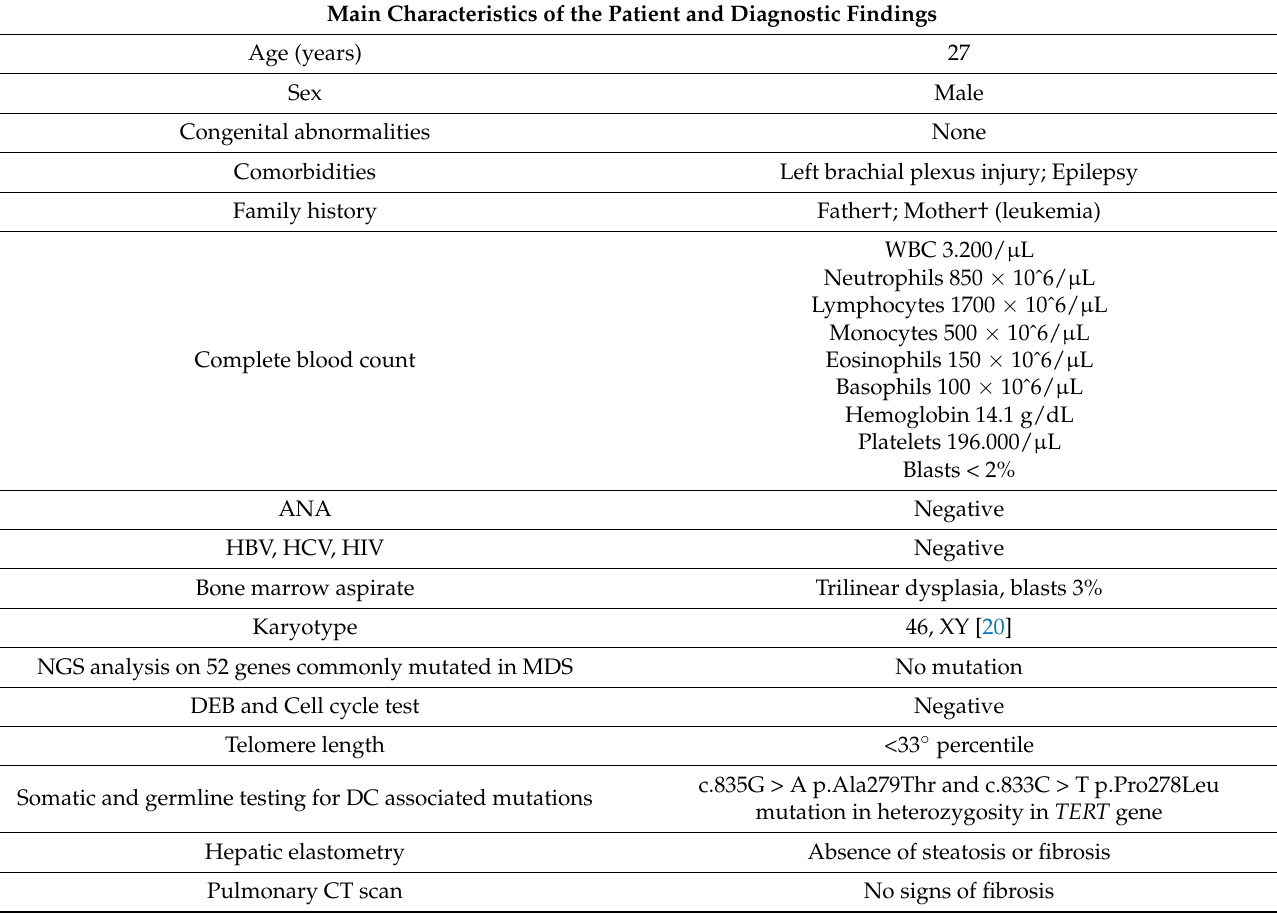
Table 2. Main characteristics of the patient and diagnostic